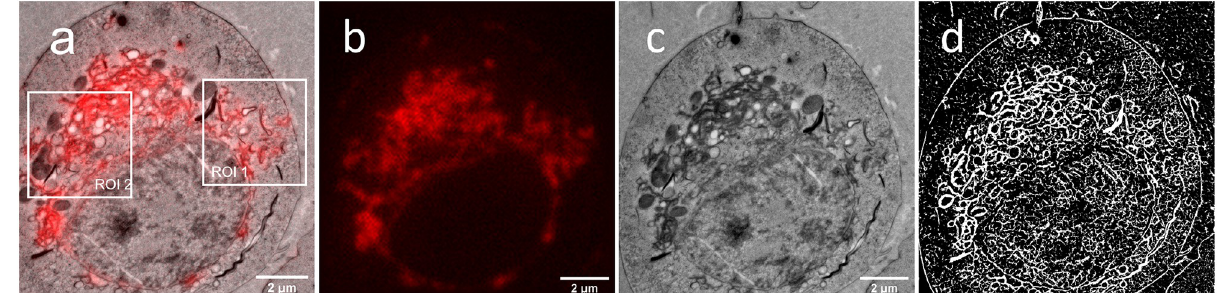
Fig 5. CLEM data of the EphA2-mVenus labeled membrane structures. a) The overlay of the wide-field fluorescence image and the correlative TEM image remains unspecific with respect to the fluorescent labeled double-layer membranes. The LM image (b) and the TEM image (c) show the same region of interest as (a). d) Membrane information was extracted by machine learning with the software Weka Segmentation.